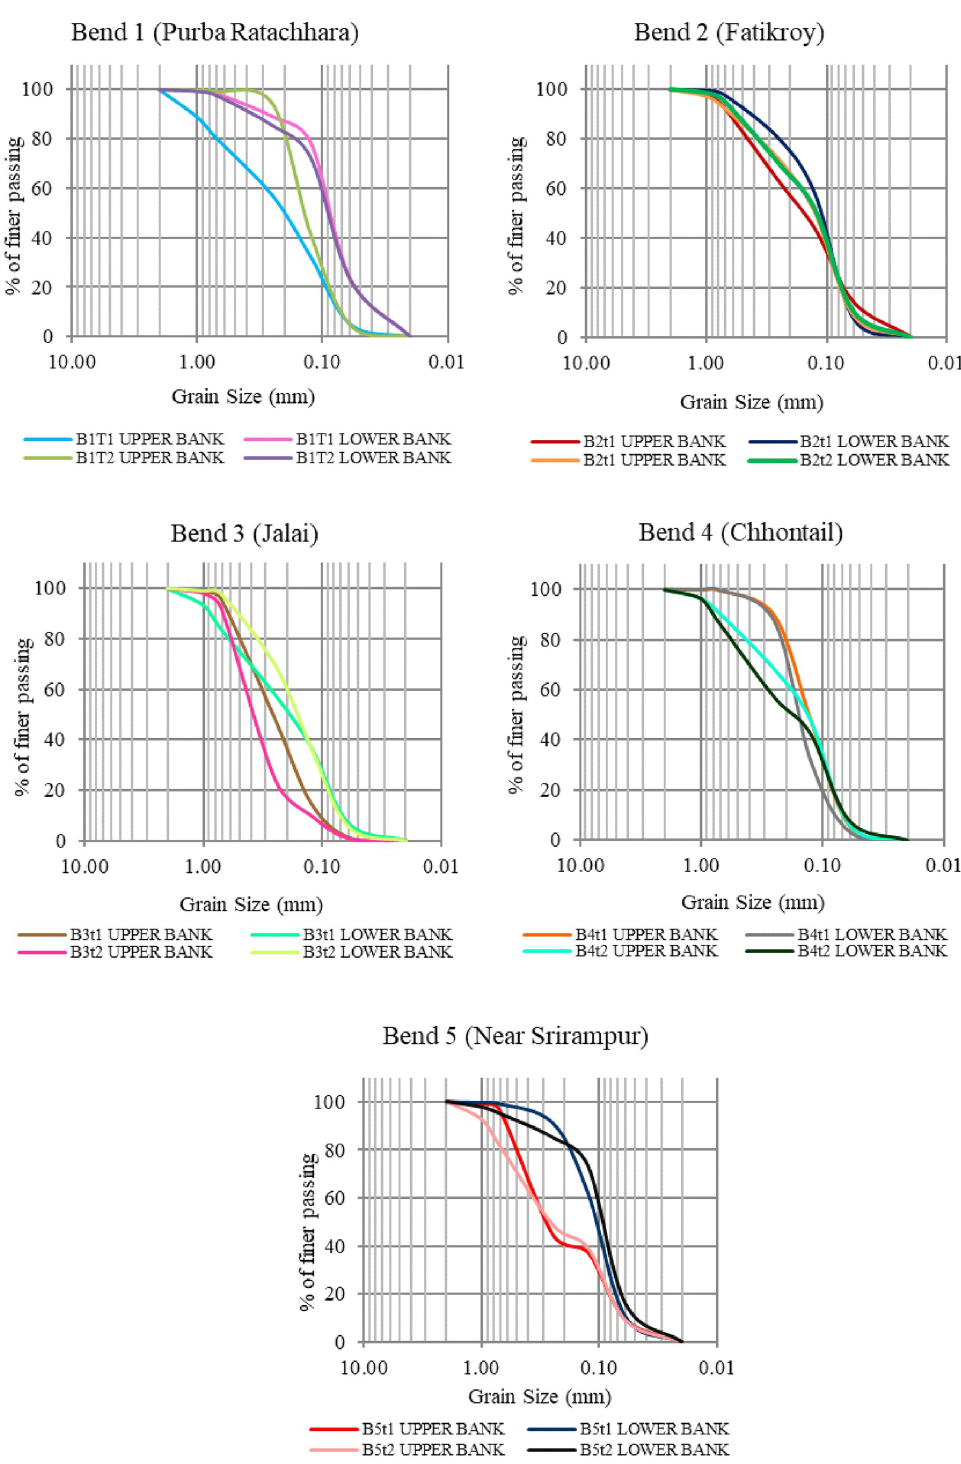
Fig 16. Grain size distributions using USCS in upper and lower bank soil of stations t1 and t2 for the five selected bends.